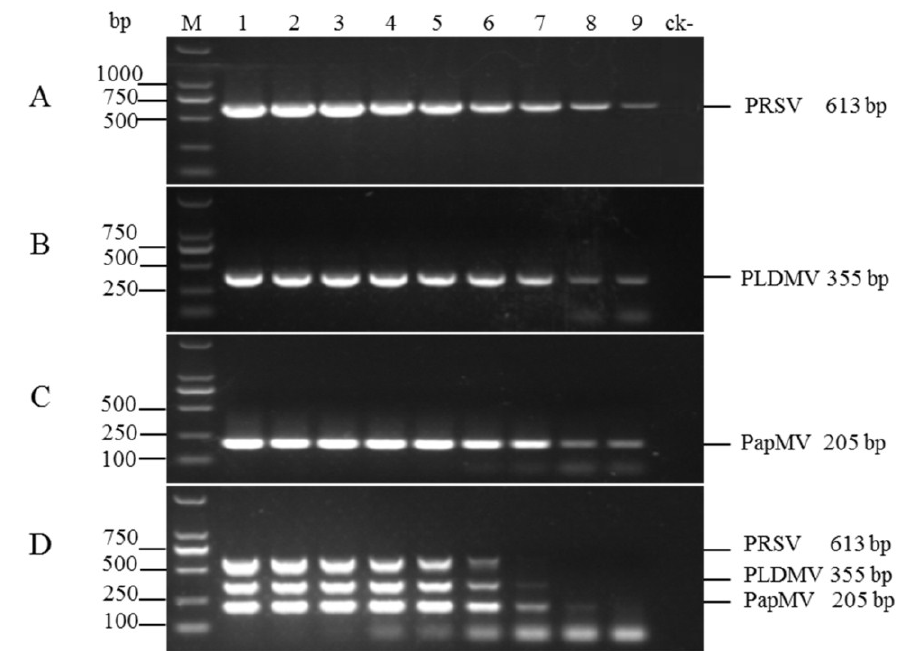
Figure 4. Comparison of the sensitivities of uniplex and multiplex RT-PCR assays for the detection of PRSV, PLDMV, and PapMV. Fragments 613 bp, 355 bp, and 205 bp of PRSV ( A ); PLDMV ( B ); and PapMV ( C ), respectively, were amplified from 10-fold